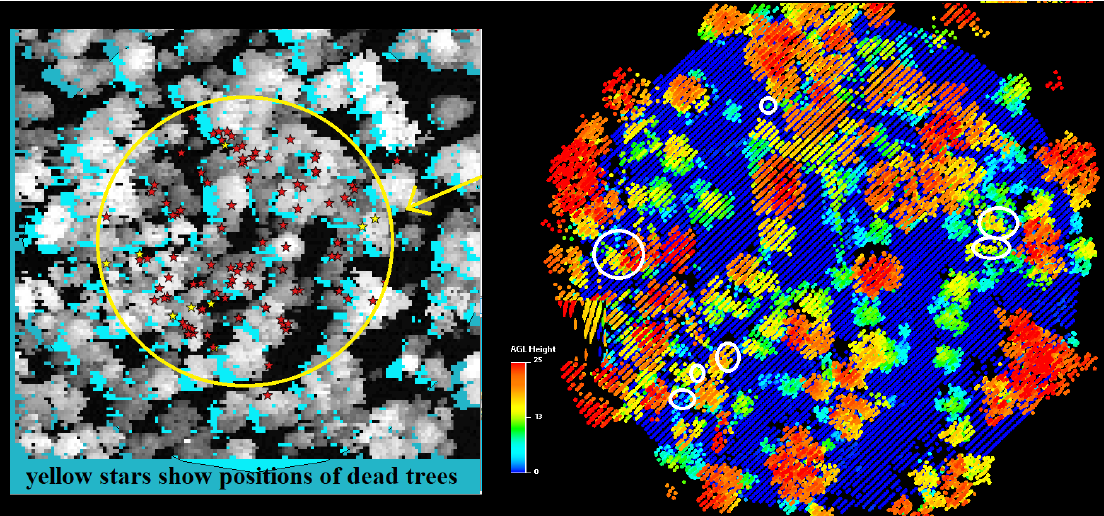
Figure 2. Example of a field plot for understanding the complexity of detecting dead eucalypt trees. The image on the left depicts the locations of both live (red stars) and dead (yellow stars) trees on Canopy Height Model (CHM). The image on the right shows the airborne laser scanning data, created by processing waveform data, and the estimated locations of the dead trees are shown in circles.